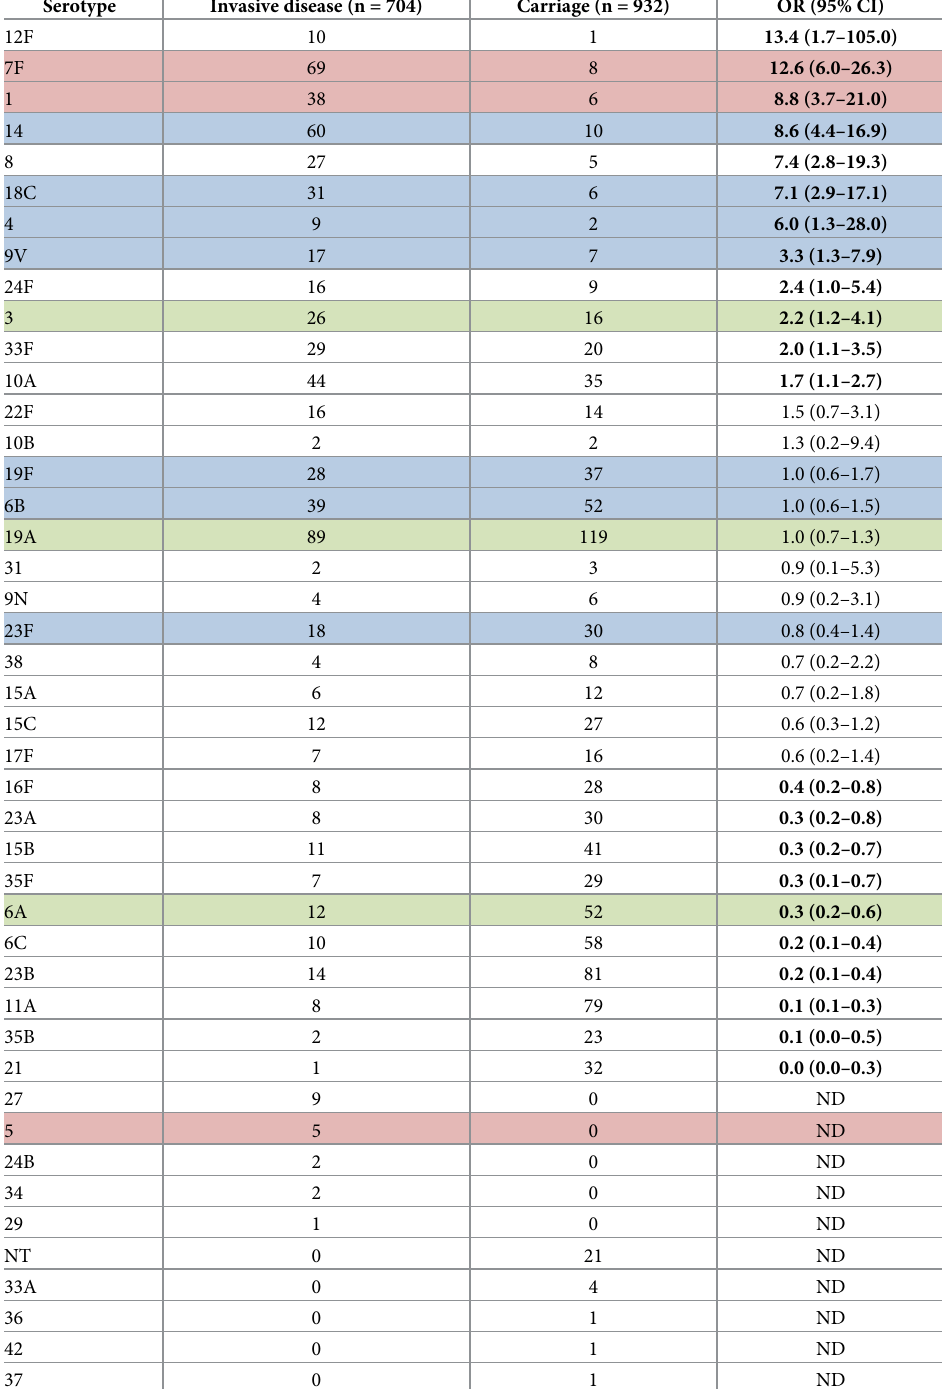
Table 2. Odds ratios for invasive disease potential of serotypes were calculated using nationwide IPD data (chil- dren < 5 years) and carriage data (24-month-old children) from 2004–2016.